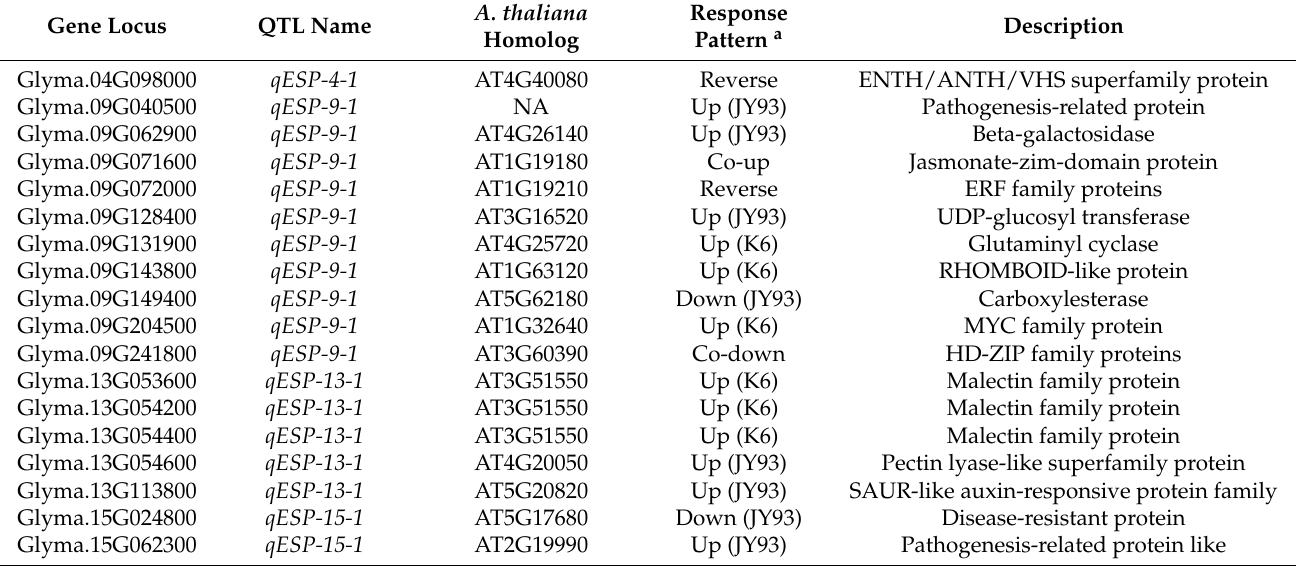
Table 4. Candidate genes of four ESP-related QTLs.